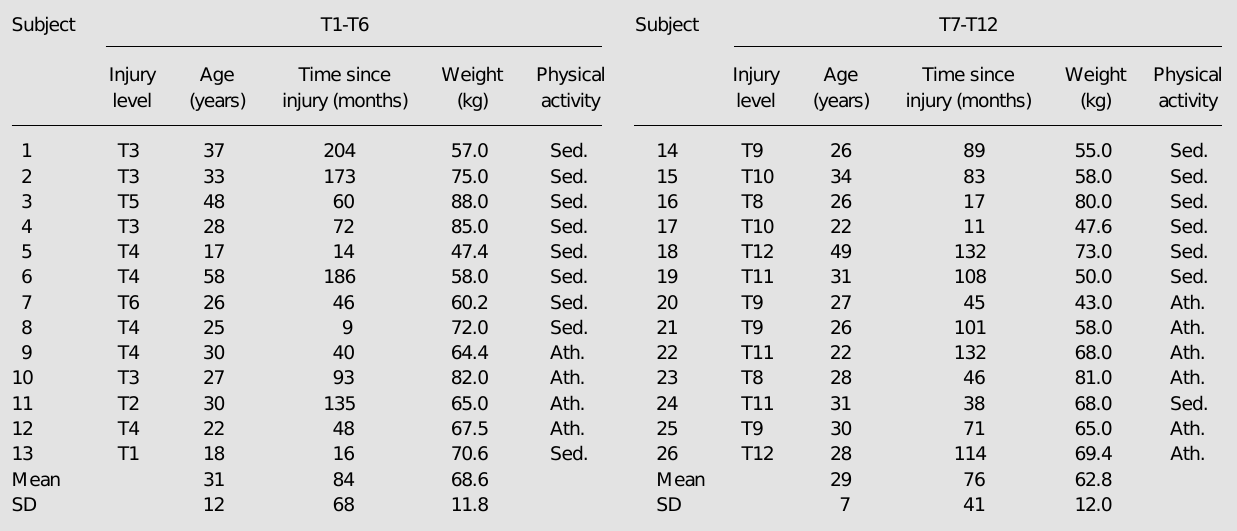
Table 1 - Anthropometric data of subjects with complete paraplegia. Sed.: Sedentary; Ath.: athlete (regularly involved in sports activity). There were no significant differences between groups (Mann-Whitney